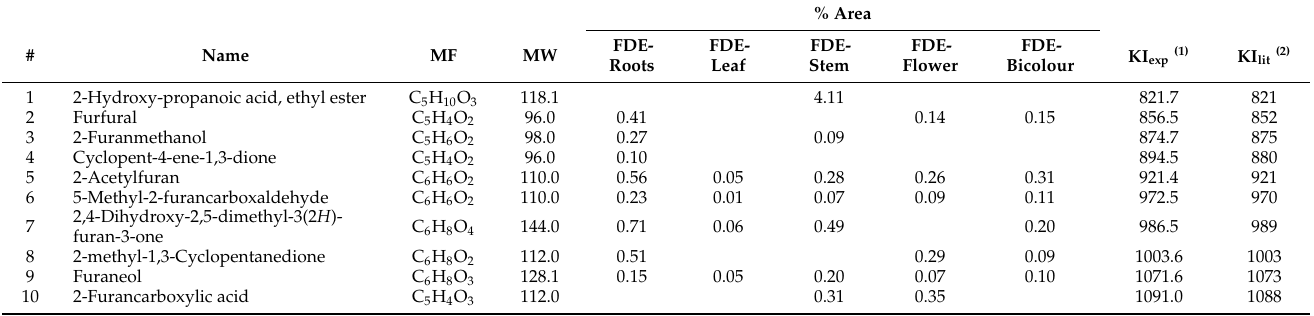
Table 4. Volatile and semi-volatile compounds identified in FDEs of Pelargonium peltatum by GC-MS. %